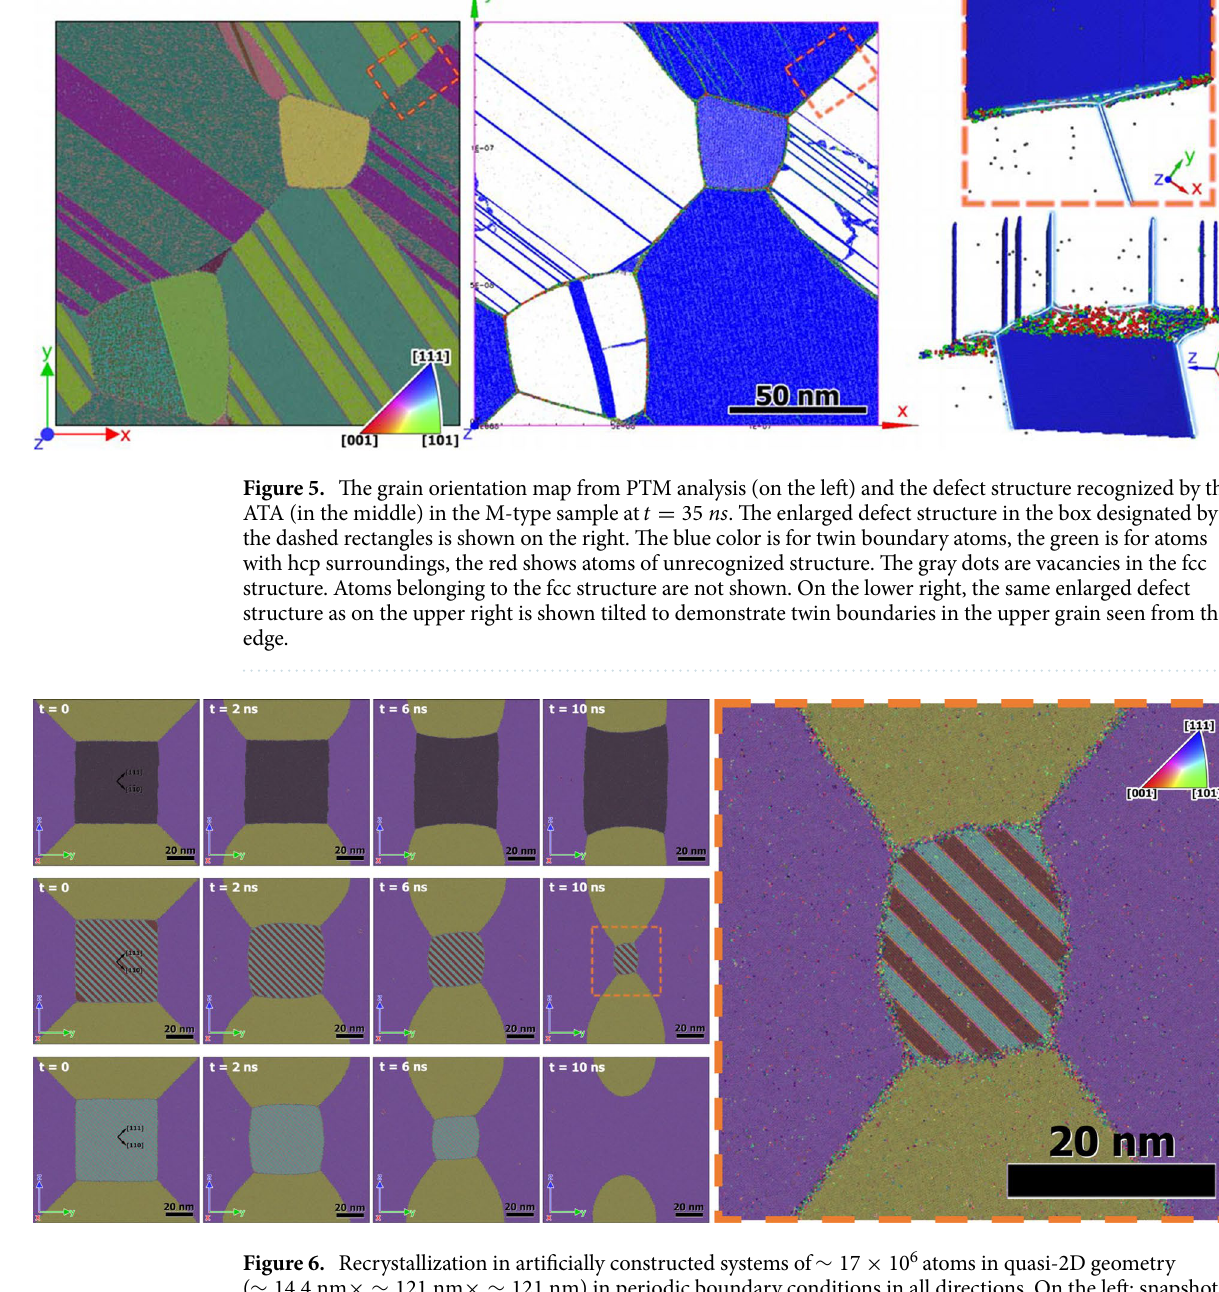
grain of initial size ∼ 60 × 60 nm was put in the centre of the samples shown in the upper left corner of Fig 6.